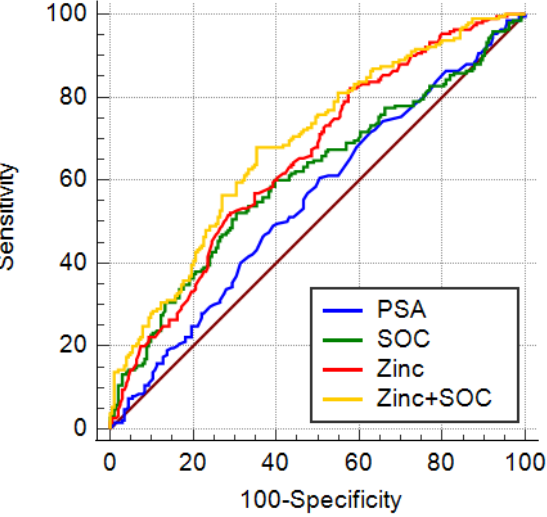
Figure 3. Diagnostic performance in detecting csPCa: AUC ROC for standard parameters PSA (blue line), SOC (PSA, age, DRE, green line), Zinc (red line), combination of zinc and SOC (Zinc + SOC, yellow line).